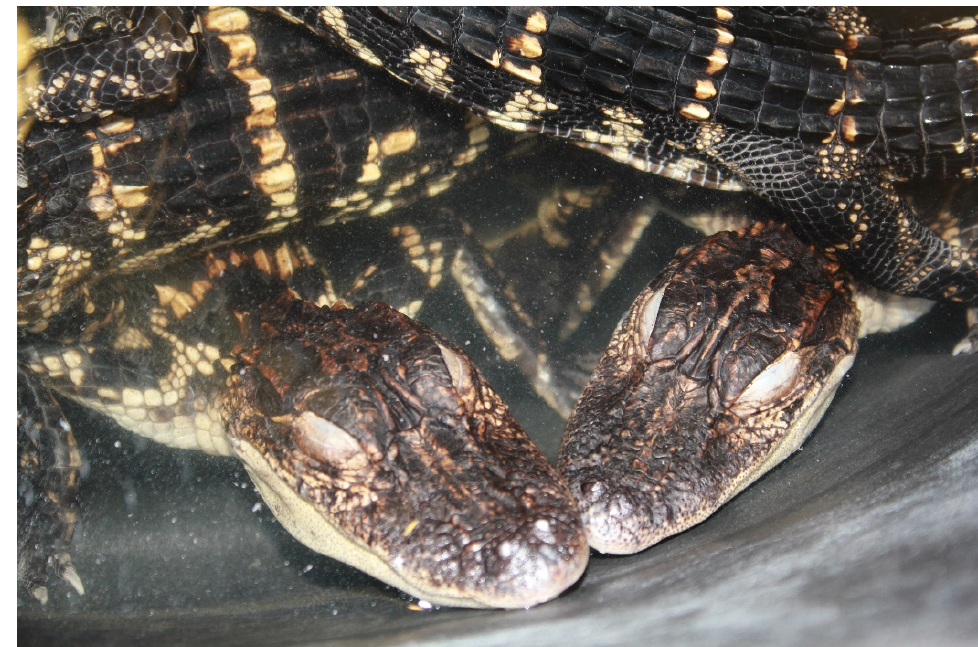
Saltwater-Exposed Juvenile Alligators Displaying ‘Eyes Closed’